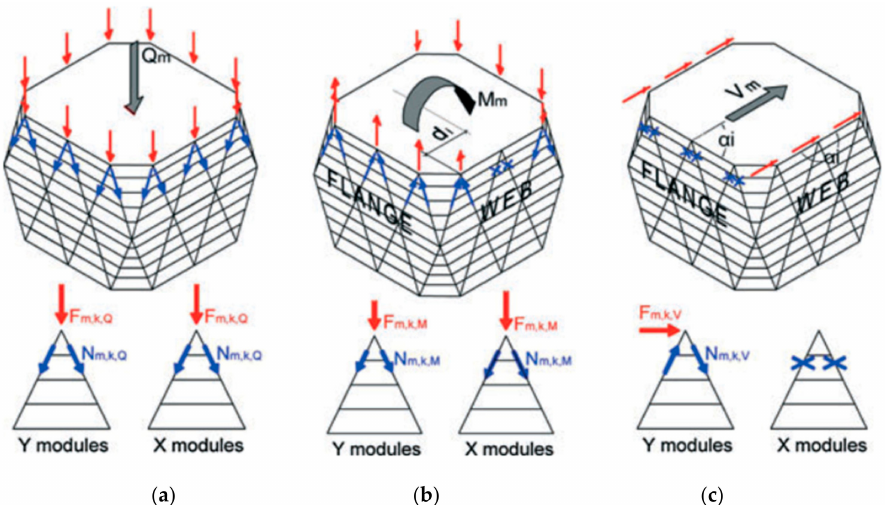
Figure 5. Scheme of the elementary diagrid module for the definition of the strength-based approach to the diagrid preliminary design, under: ( a ) gravity loads; ( b ) overturning moment; ( c ) shear force. Used with permission from Montuori et al.